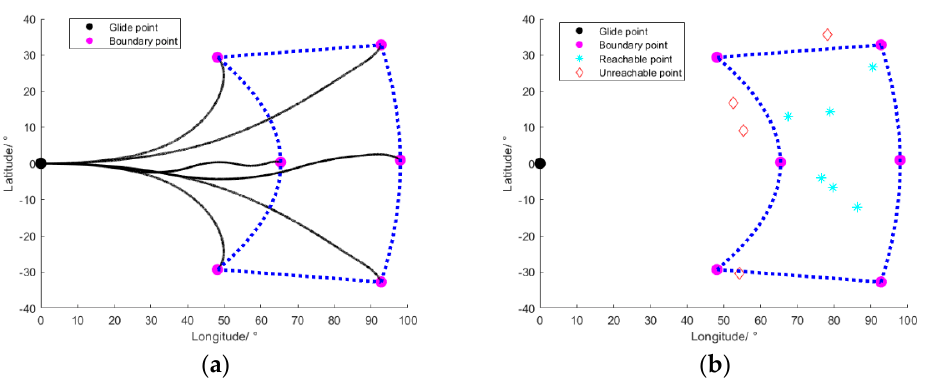
Figure 5. The reachability discriminant for new target points by SPM: ( a ) is the travel history; ( b ) is the reachability discriminant result.